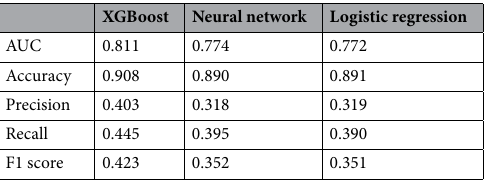
Table 3. Predictive ability of the model using test data. AUC the area under the receiver operating characteristic curve.